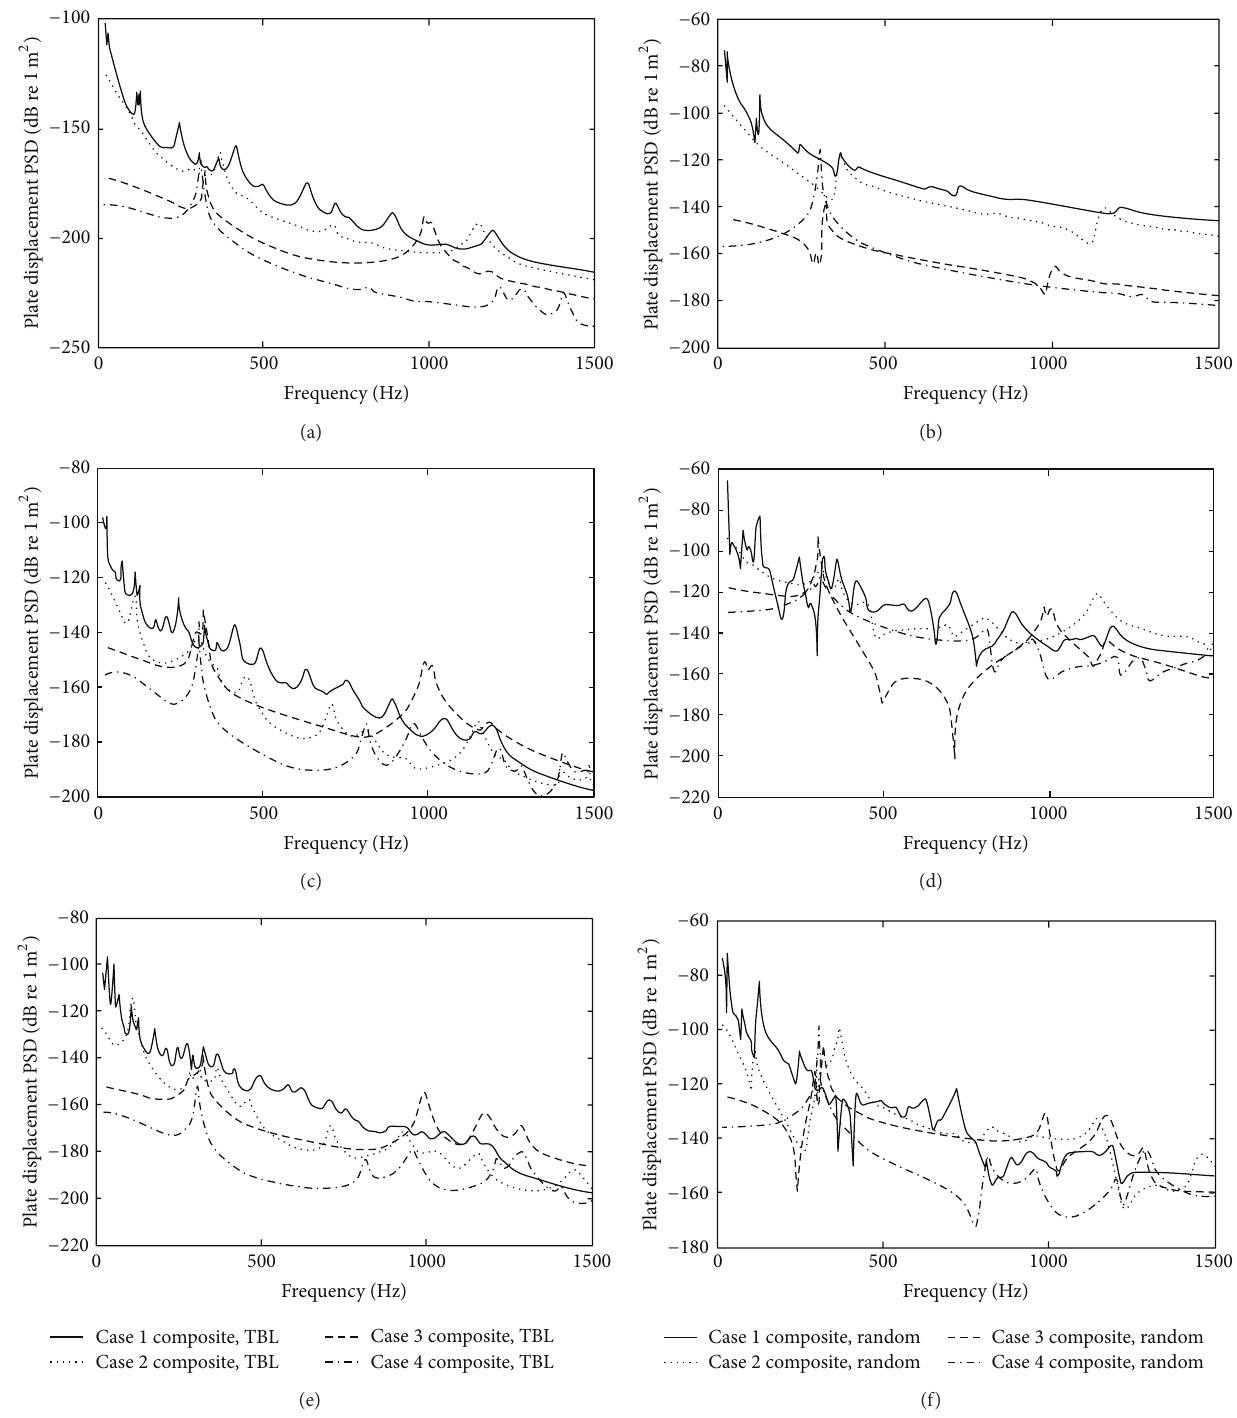
Figure 5: Panel displacement PSD results for the composite panels: (a) and (b) overall panel 𝑆 𝑤𝑤 ; (c) and (d) 𝑆 𝑤𝑤 near surface location , 𝑦 ) = (0.5𝑎, 0.5𝑏) ; (e) and (f) 𝑆 (𝑥 1 1